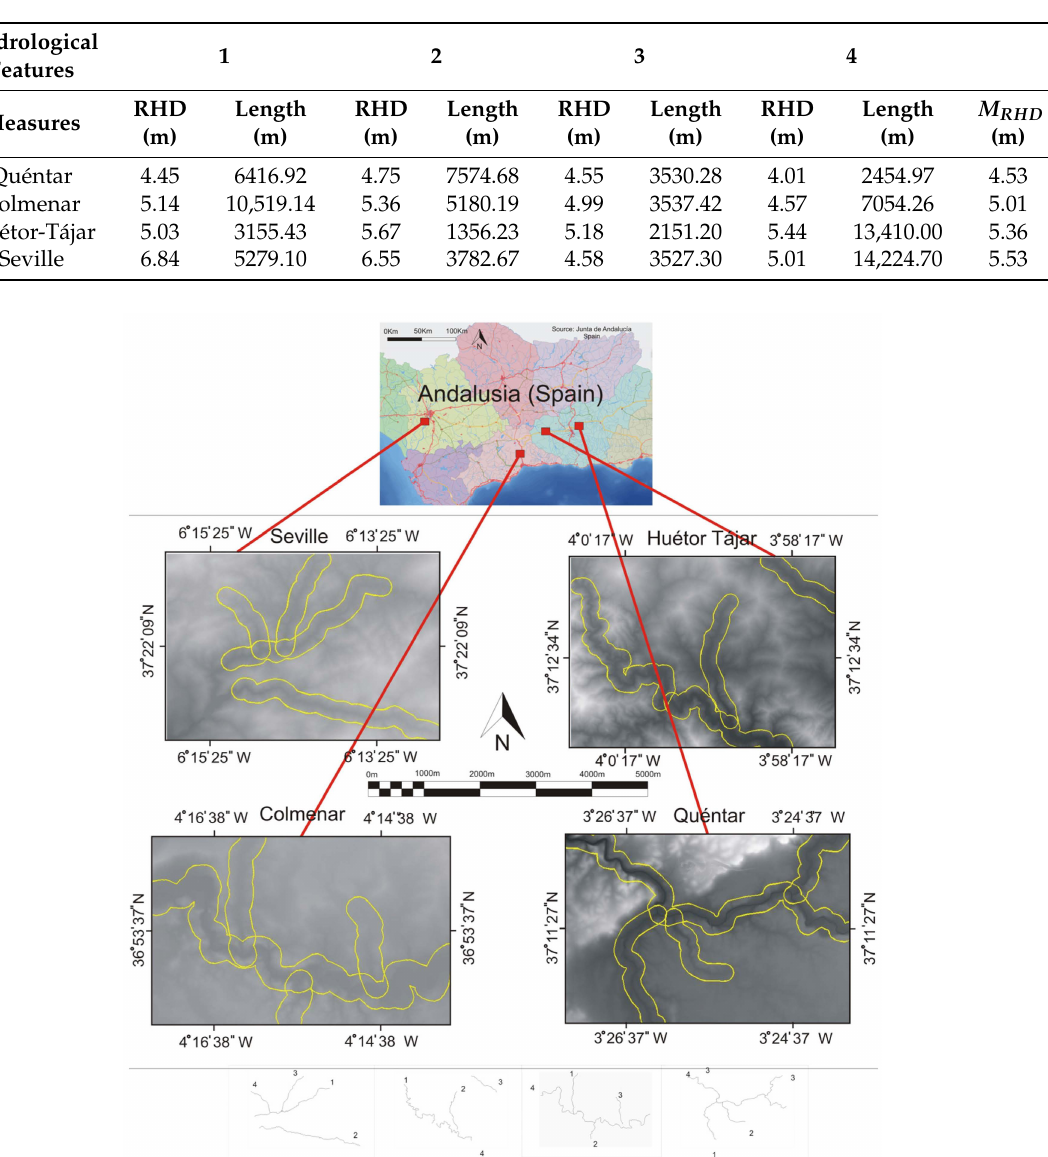
Real displacement (RD) between homologous DEMs computed comparing linear hydrological features.